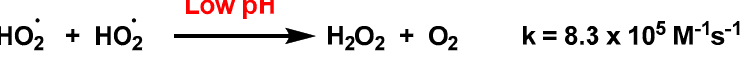
Figure 26. Disproportionation reaction of HO 2• and rate constant.